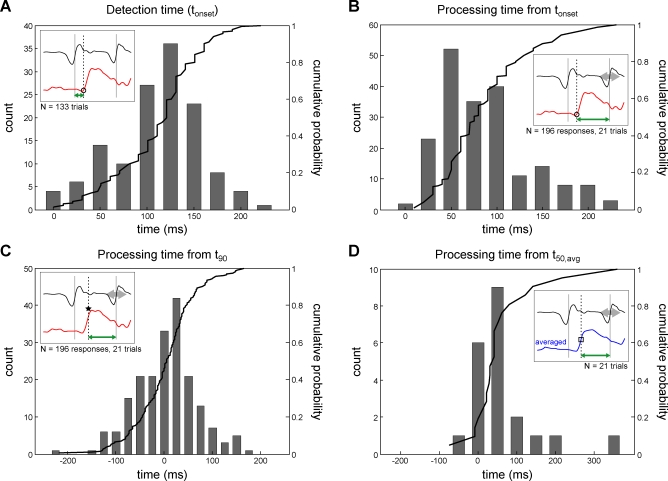
Odorant Detection and Processing Times Estimated from Optical Imaging of Receptor Inputs(A) Histogram and cumulative probability plot of optical signal-onset latencies measured from all imaged trials (median, 120 ms). Time bin is 25 ms. In all panel insets, green arrows and vertical dotted lines indicate the interval measured in the panel, overlaid on sample respiration (black) and either optical response (red) or averaged response (blue) traces. Circle indicates response onset time.(B) Histogram and cumulative probability plot of processing times based on the time from optical signal onset to the start of the second inhalation (median, 75 ms). Time bin is 25 ms.(C) Histogram and cumulative probability plot of processing times based on the time of the 90% maximum of the optical signal (star in optical signal trace). Many values are negative (median, 6 ms), indicating that the next sniff occurs before the first response has peaked. Time bin is 25 ms.(D) Histogram and cumulative probability plot of processing times based on the time to half-maximal activation of the average response across all responding glomeruli in each trial (median, 40 ms). Time bin in 50 ms.In (B), (C), and (D), the end of the interval measured was the time of the second inhalation, as indicated by the gray arrows in the inset.